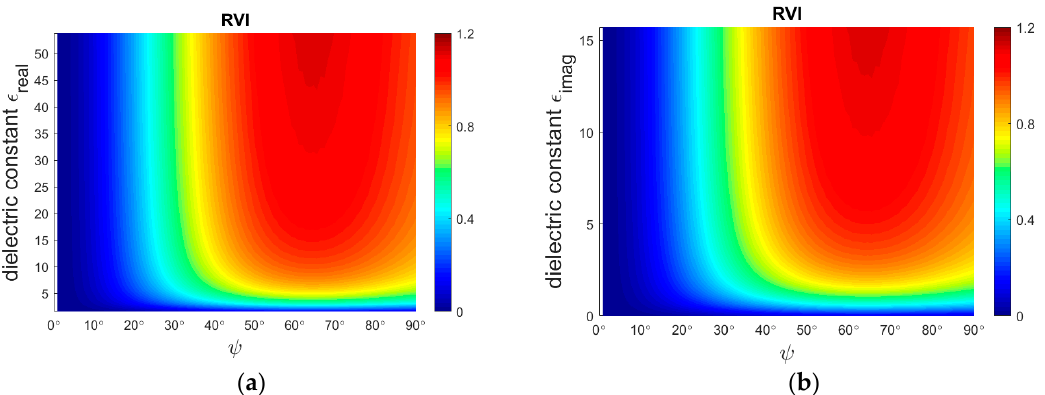
Figure 4. Density plots of modeled RVI [-] as a function of the vegetation structure parameter ψ [deg] and the complex dielectric constant ε v [-] of vegetation (after Ulaby & El-Rayes [29]), split in real ( a ) and imaginary ( b ) part for the prolate spheroid scenario.